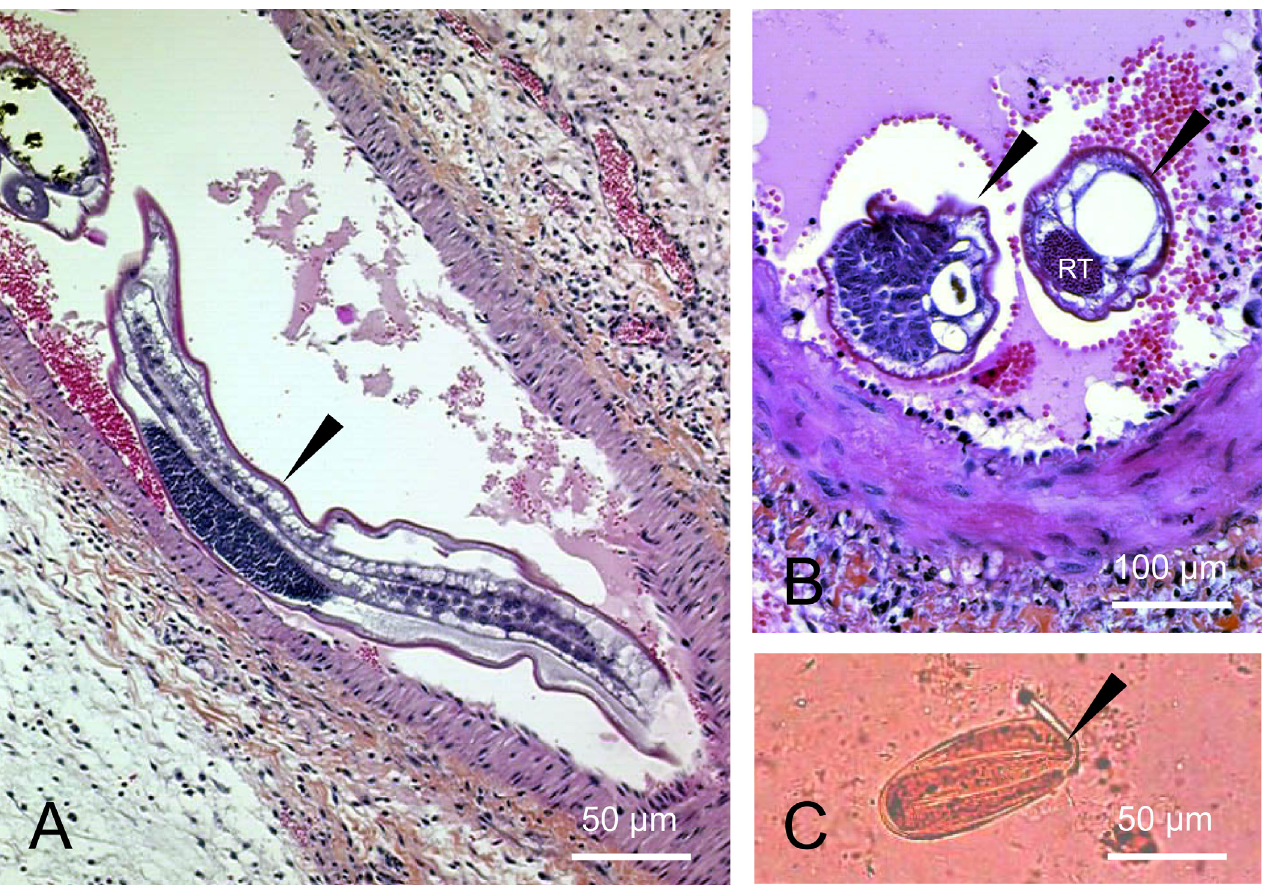
Figure 2. Microscopical aspects of the ileal specimen and parasitic stools examination of case No. 1. A. Longitudinal section of a mesenteric artery with an A. costaricensis adult inside arterioles ( dart ) (HES, 100x). B. Cross section of intra-mesenteric arterial adult nematodes ( darts ) with an eosinophilic in fl ammatory in fi ltrate inthe surroundingtissues. Oneharbors a reproductive tube (RT) (HES, 100x). C. Impaired embryonated egg of nematode (maybe A. costaricensis ) ( dart ) measuring 80 (cid:3) 35 m m (MIF, 200x) found in stools collected four days after abdominal surgery.